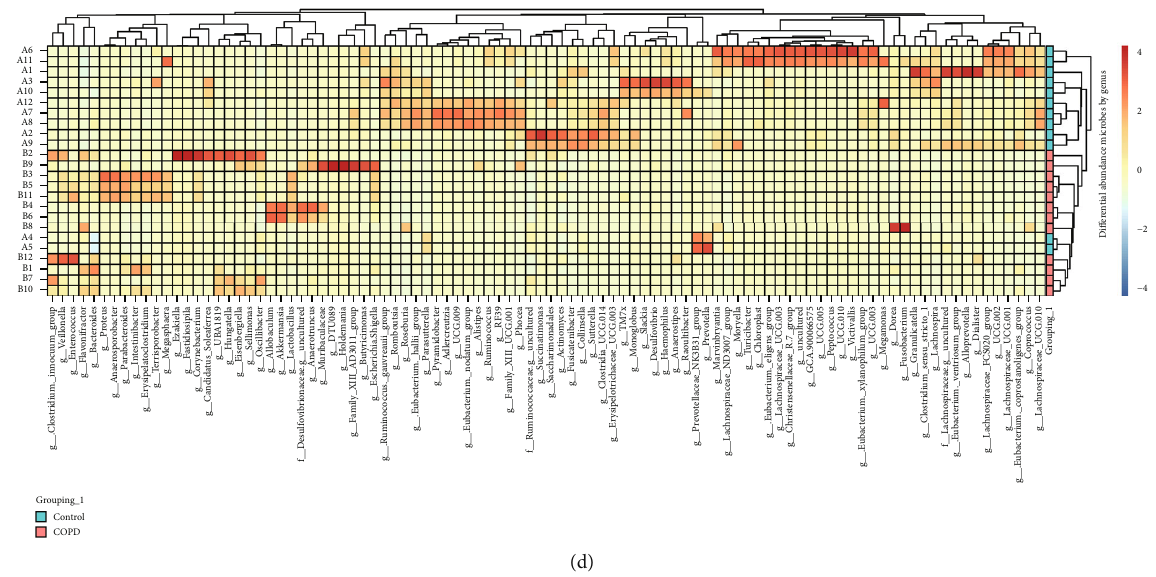
Figure 3: Diversity and di ff erential changes of intestinal microbiota in COPD patients. (a) Alpha diversity index. (b) Beta diversity index. (c,d) Heatmap of species di ff erence at phylum and genus